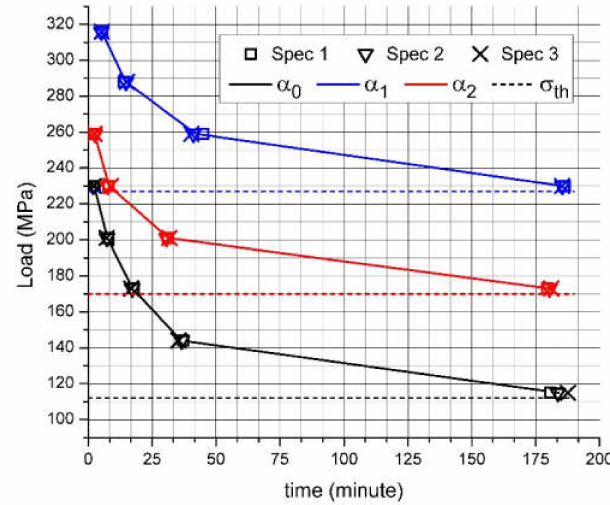
Figure 3. SCC threshold for varied surface preparation set up.